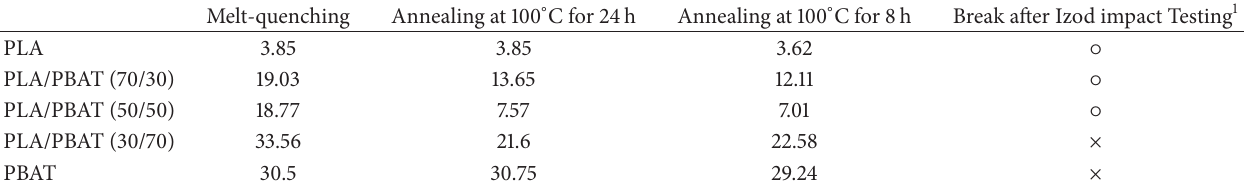
Table 4: The impact strength (KJ/m) for all samples under the melt-quenching and various annealing. Melt-quenching Annealing at 100 ∘ C for 24h